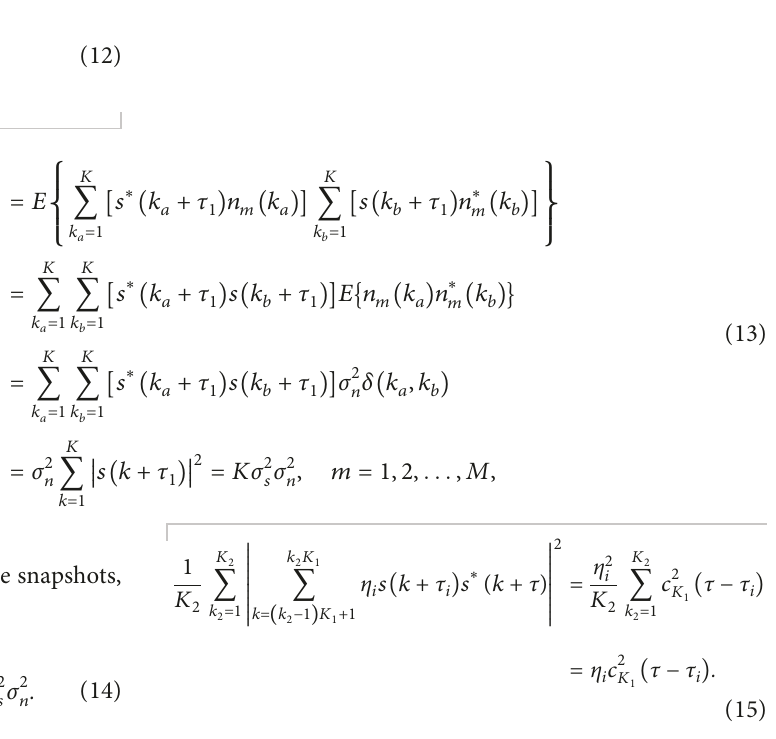
Comparing with r K ( τ ) in (9), the form of r K (12) is also similar with OAS. We call the combination path with time delay τ is enhanced. The difference and equivalence of OAS in (1) and EAS in (12) are described in Table 3. Assuming that the snapshots are infinite, according to the discrete time matched filters theory, the noise element at m th antenna is